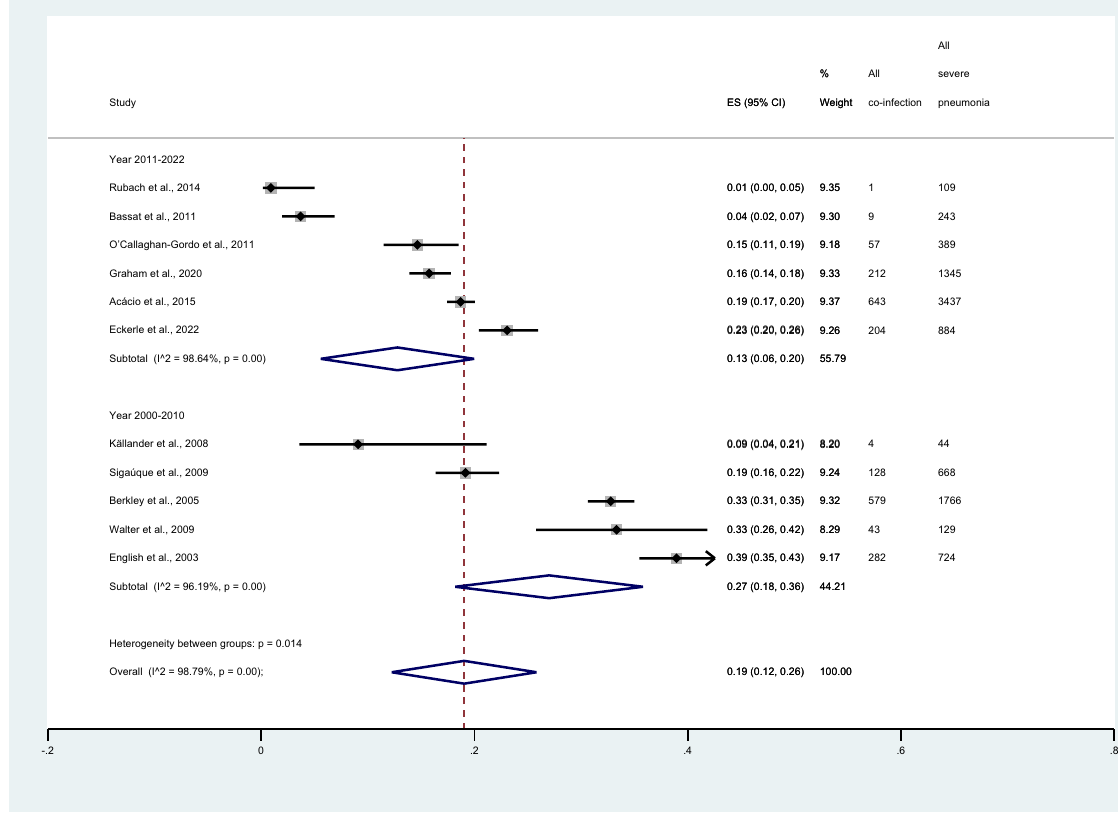
Figure 3. Forest plot demonstrates the pooled proportion of malaria among patients with severe pneumonia sub grouped by publication years. ES, proportion estimate; CI, confidence